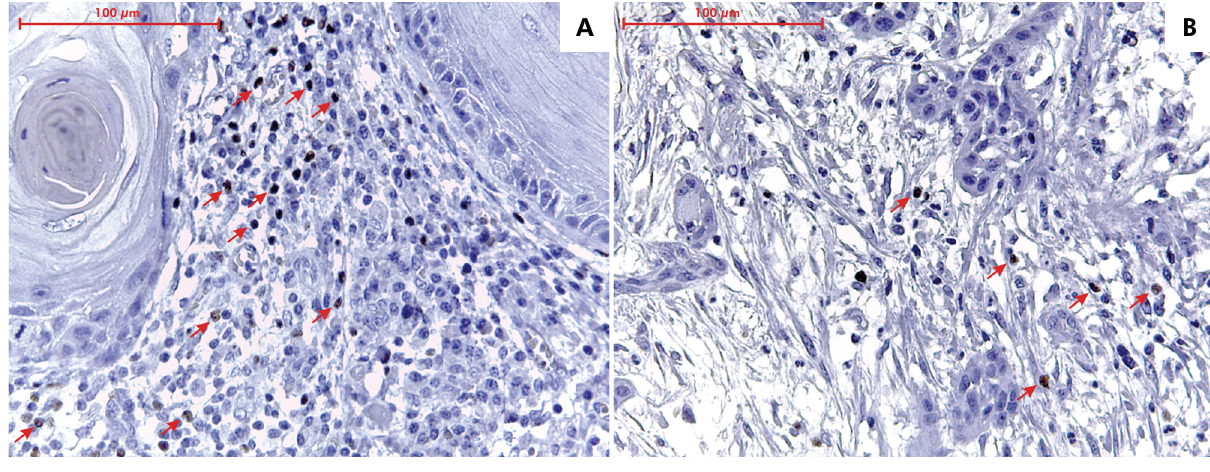
Figure 1. A) Many FoxP3+ lymphocytes (arrows) at the invasive front of low-grade OTSCC in older patient exhibiting marked inflammatory infiltrate (Reveal, 400×). B) Few FoxP3+ lymphocytes (arrows) at the invasive front of high-grade OTSCC in young patient exhibiting slight inflammatory infiltrate (Reveal, 400×).